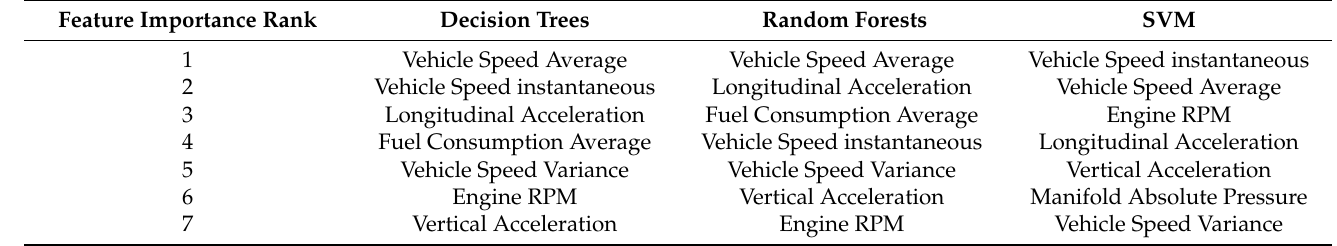
Table 10. Driving style feature importance using the permutation feature importance